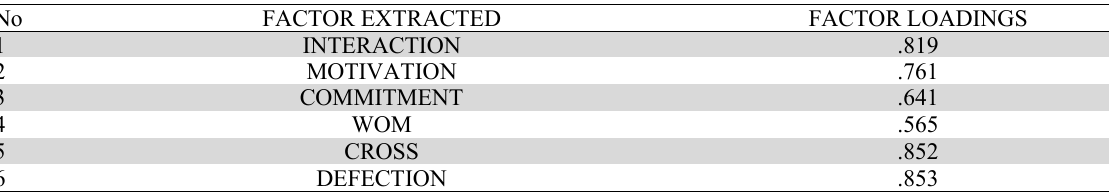
Component extracted